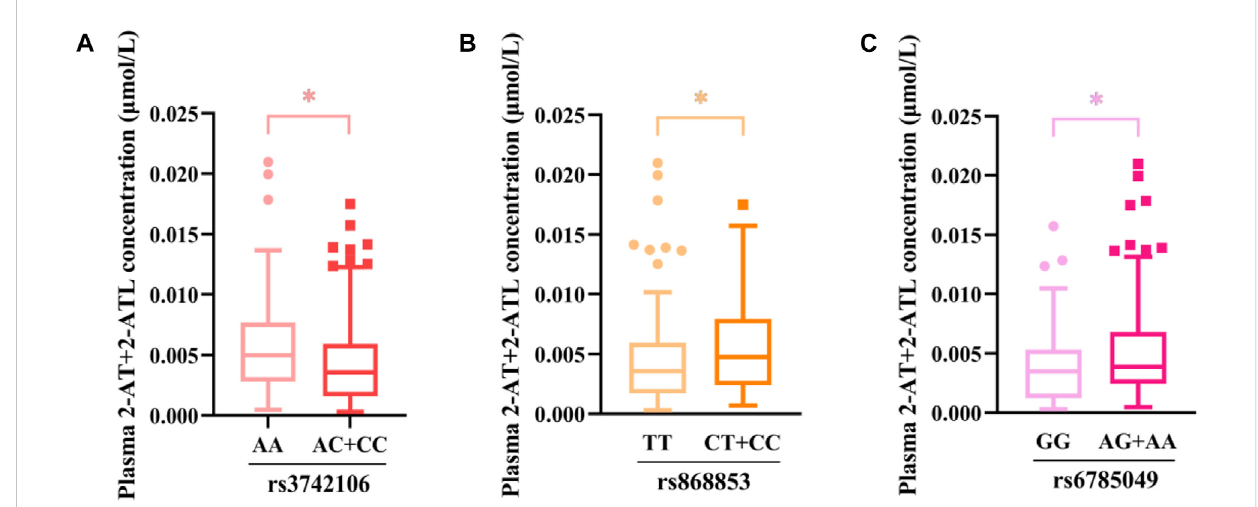
FIGURE 3 Association between genetic variants and the plasma concentration of 2-AT+2-ATL as determined using the Mann – Whitney U test. * p < 0.05. (A) rs3742106; (B) rs868853; (C)